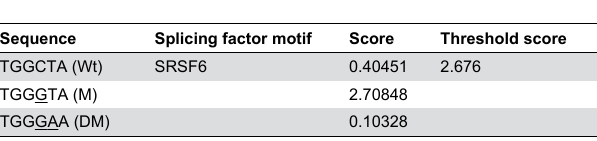
Legend: the mutated nucleotides are underlined; Wt = wild-type; M = mutant; DM = double mutant.